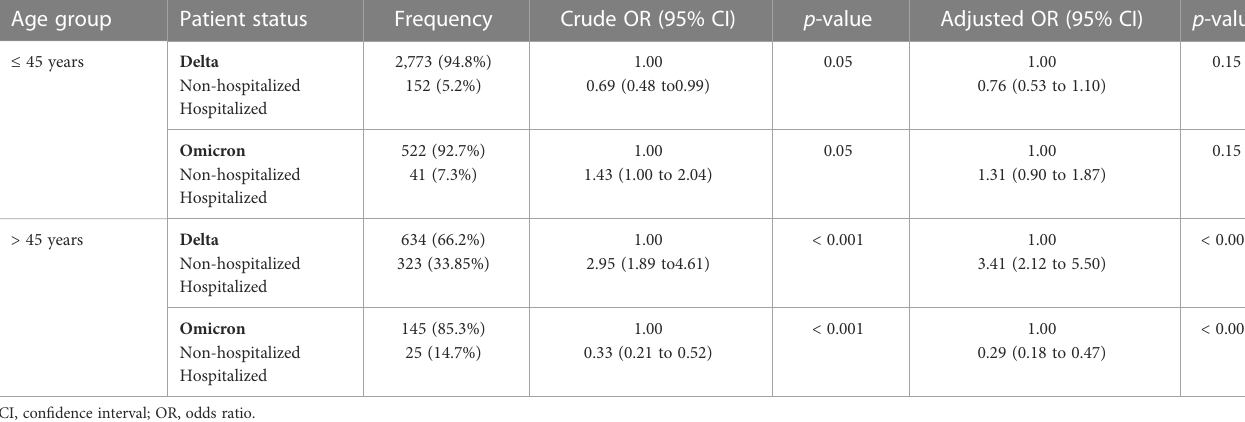
TABLE 2 Patient status strati fi ed by age group (i.e., ≤ 45 years and > 45 years), analyzed by the variant of concern (either the Delta or the Omicron variant) in association with hospitalization status (i.e., non-hospitalized and